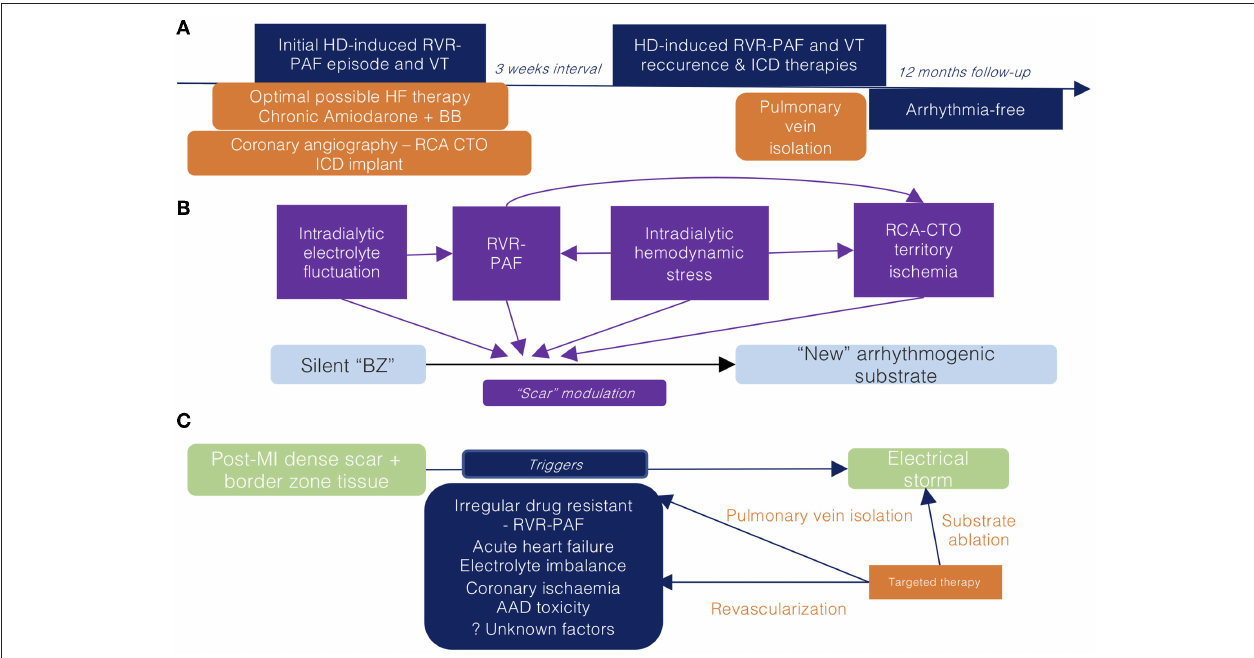
FIGURE 4 | (A) Clinical timeline of relevant data concerning the current episode of care (B) Co-factors leading to scar modulation promoting ventricular arrhythmia during hemodialysis (C) Potential therapies targeting the multiple promoters of the current electrical storm episode. RVR-PAF, rapid ventricular response paroxysmal atrial fibrillation; HD, hemodialysis; VT, ventricular tachycardia; RCA, right coronary artery; CTO, chronic total occlusion; BZ, border zone; MI, myocardial infarction; HF, heart failure; BB, beta-blocker; AAD, antiarrhythmic drug; ICD, implantable cardioverter